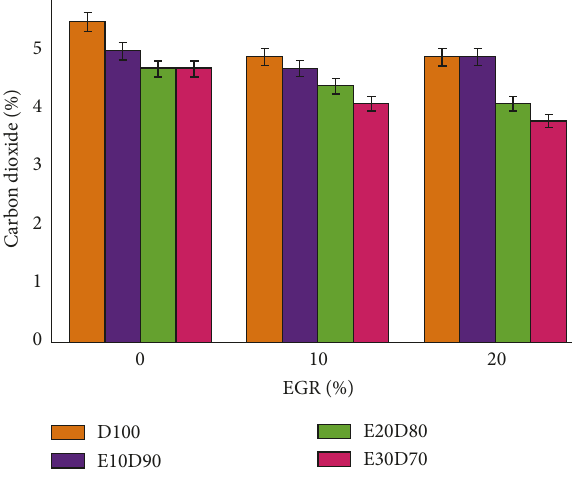
Figure 14: Variation in CO load.